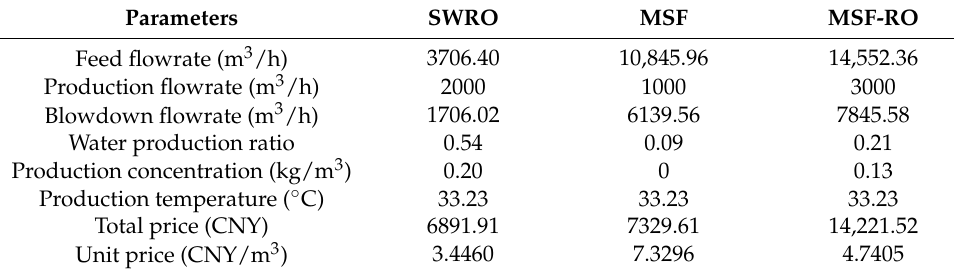
Table 13. Overall water production in option